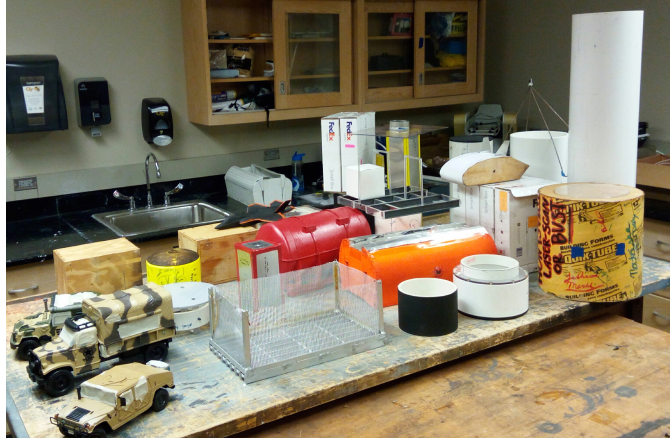
Figure 5. Some of the models on which aerodynamic load maps have been generated in the wind tunnel using the continuous rotation technique. From [100] by permission of